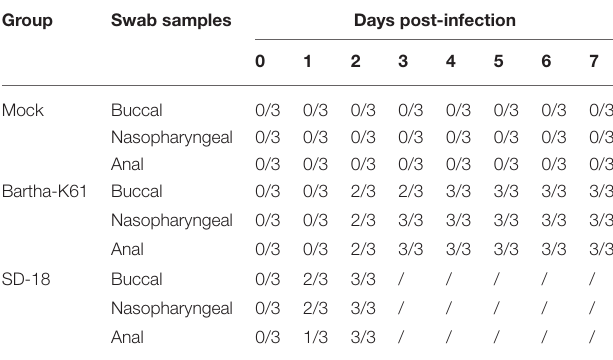
TABLE 2 | Virus detection in the excretion of challenged